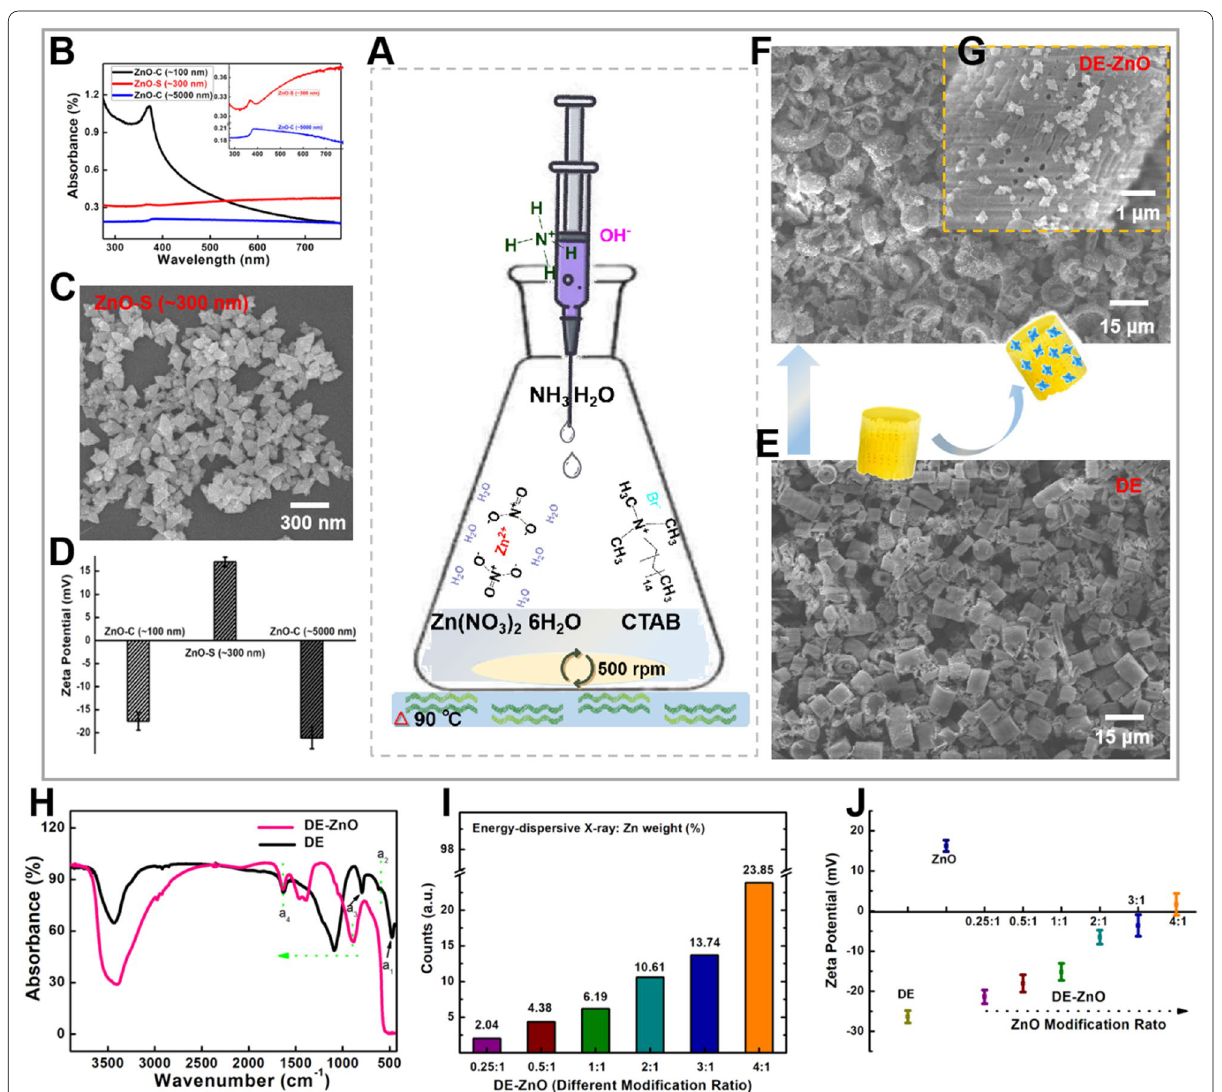
Fig. 1 Study the mild‑simple synthesis procedure and chemical characterization of nano‑composite (DE‑ZnO). A Illustration of the mild‑simple synthesis procedure of DE‑ZnO in middle of the graphic and surrounding with the property characterization. B UV–visible absorption spectra for ZnO nanomaterials (ZnO‑S, commercially available ZnO nanomaterials; ZnO‑C (~ 100 nm) and ZnO‑C (~ 5000 nm)). C SEM images of ZnO‑S (~ 300 nm). D Zeta potential of the ZnO nanomaterials. E SEM image of the precursor diatomaceous earth (DE). F SEM images of the product semiconductor nano composites DE‑ZnO, inside G. is the amplification SEM image of the DE‑ZnO surface. H FTIR spectra of